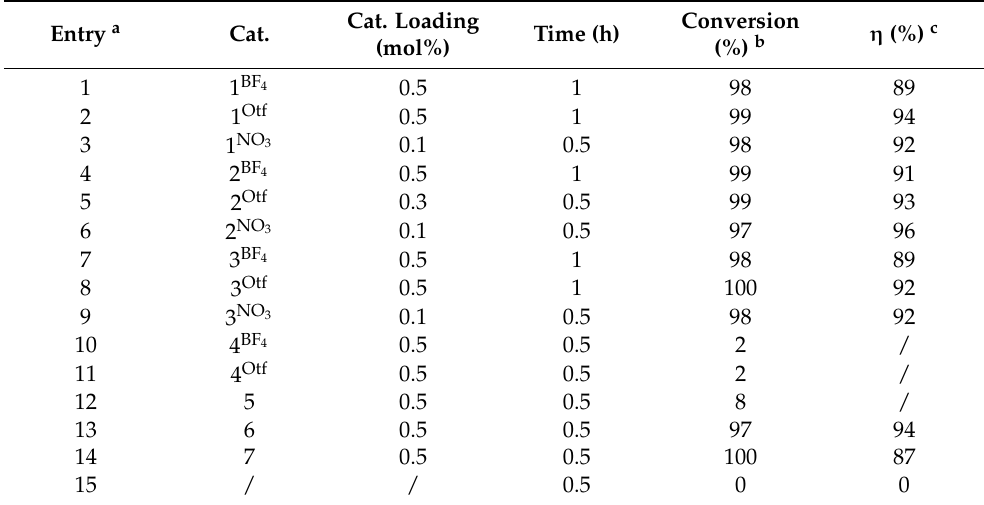
Table 2. Catalytic activities of complexes 1 X –3 X (X = BF 4 , Otf, NO 3 ) in the CuAAC reaction of phenylacetylene and benzyl